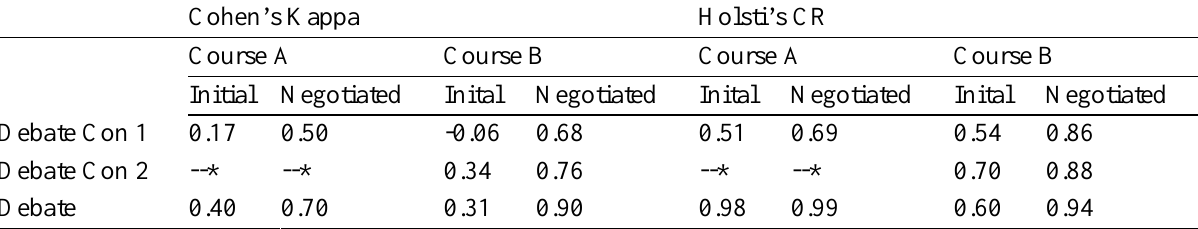
Module 2 Debate Cohen’s Kappa Holsti’s CR Course A Course B Course A Course B Initial Negotiated Inital Negotiated Inital Negotiated Inital Negotiated Debate Con